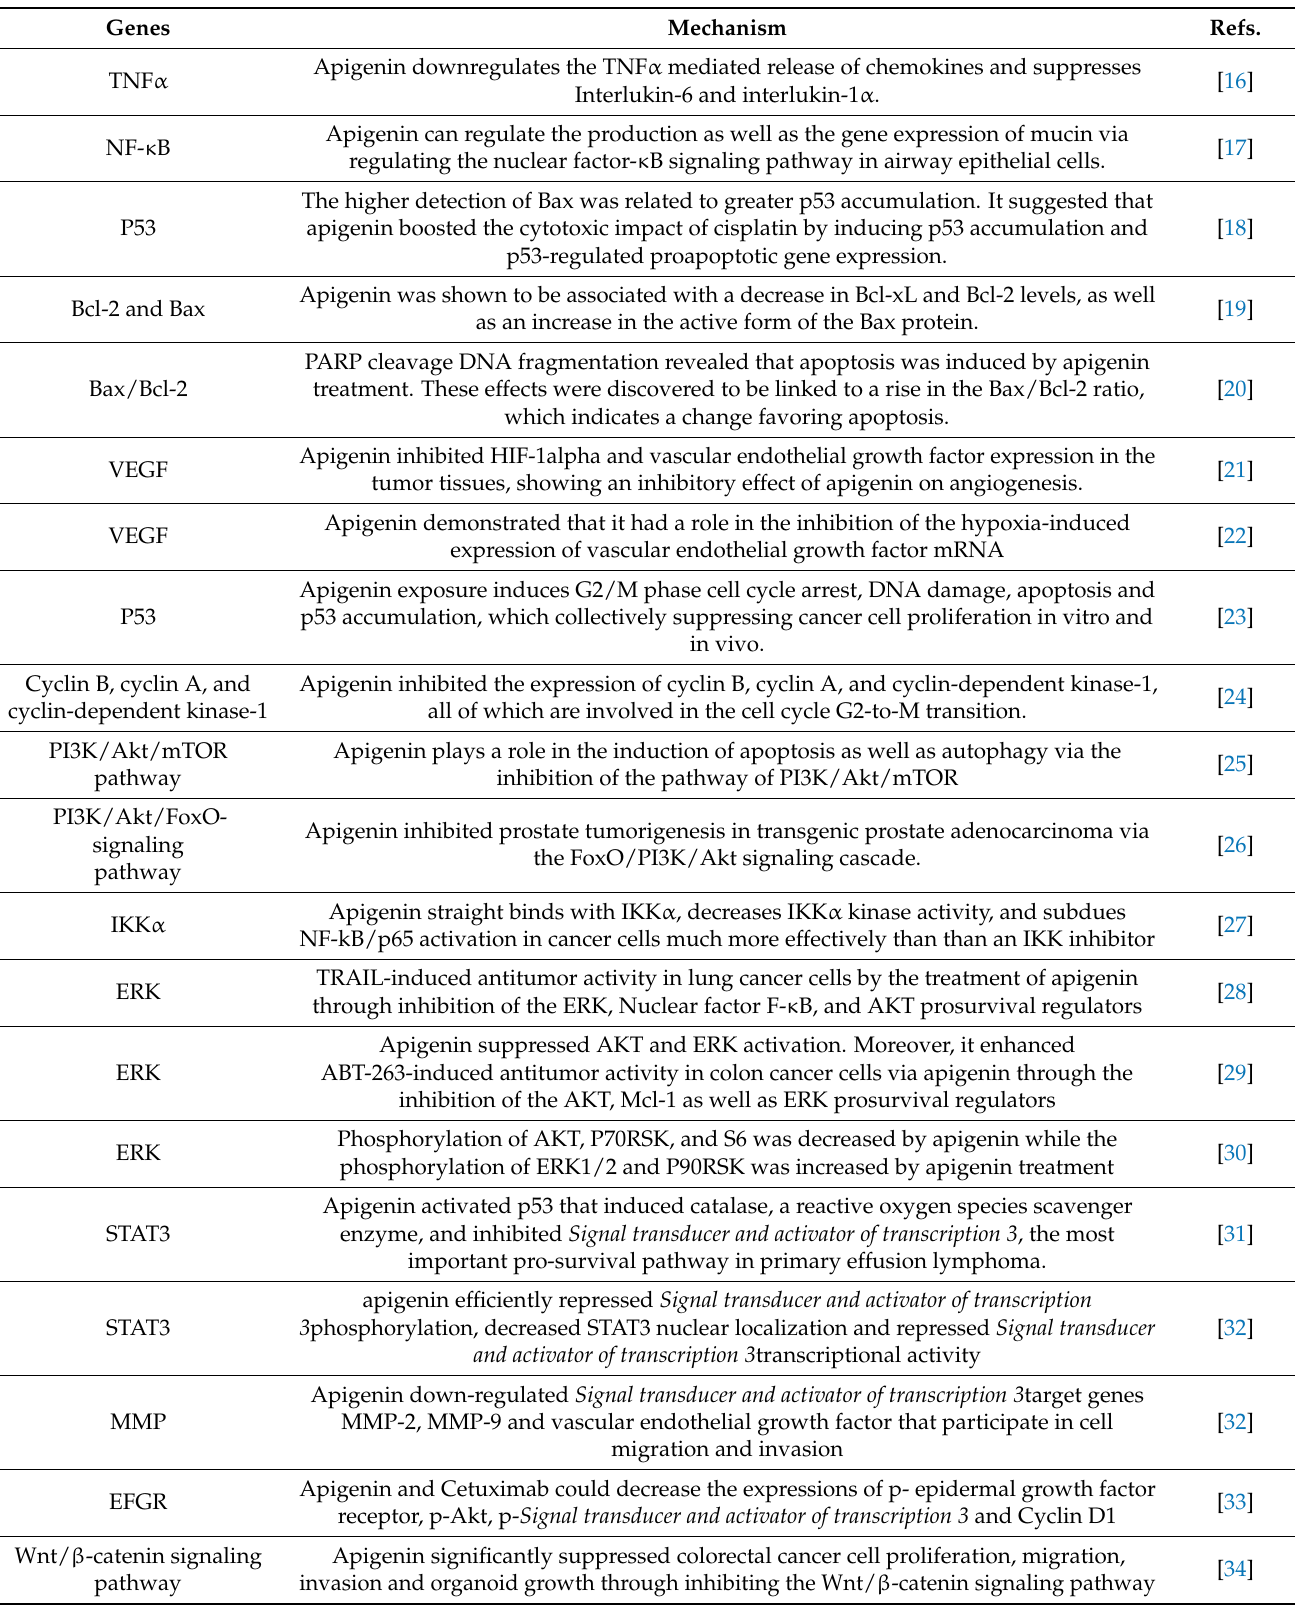
Table 1. Major mechanism of apigenin in cancer management through modulating gene activity. Mechanism